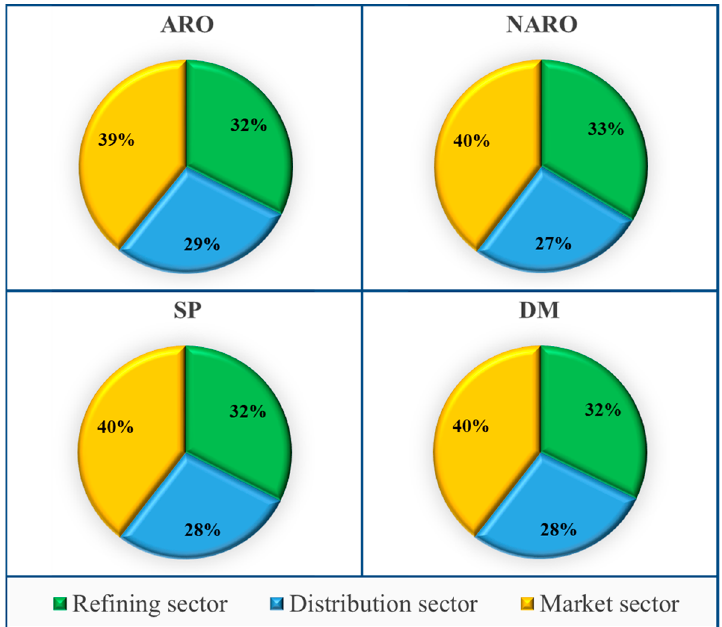
Figure 2. Contribution margins of the network echelons to the profitability.